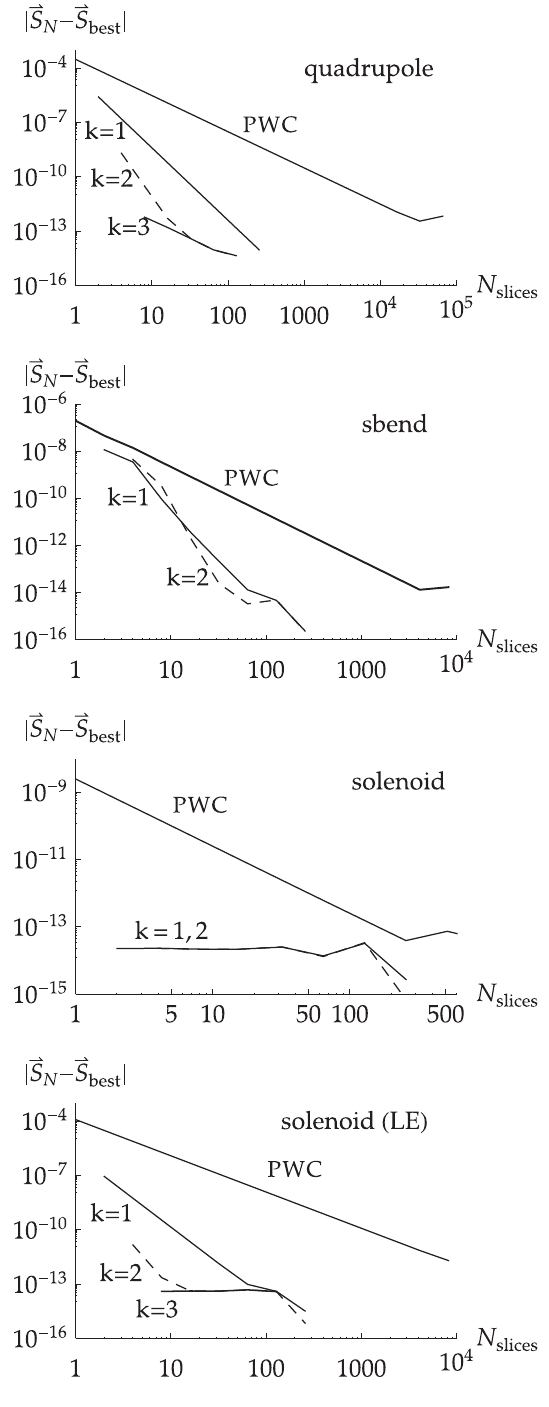
FIG. 7. Absolute error in the computed spin versus the number of slices for a proton crossing several different beam line elements. The upper three graphics show results for a 200 GeV p þ crossing a RHIC IR quad (top), a RHIC arc dipole (second), and a 2.1 m, 1.3 T solenoid (third). The bottom graphic shows the result for a 25 GeV p þ traversing the same solenoid. Each curve corresponds to a different method of integrating the spin: PWC for piece-wise constant integration; the k values indicate the number of Romberg